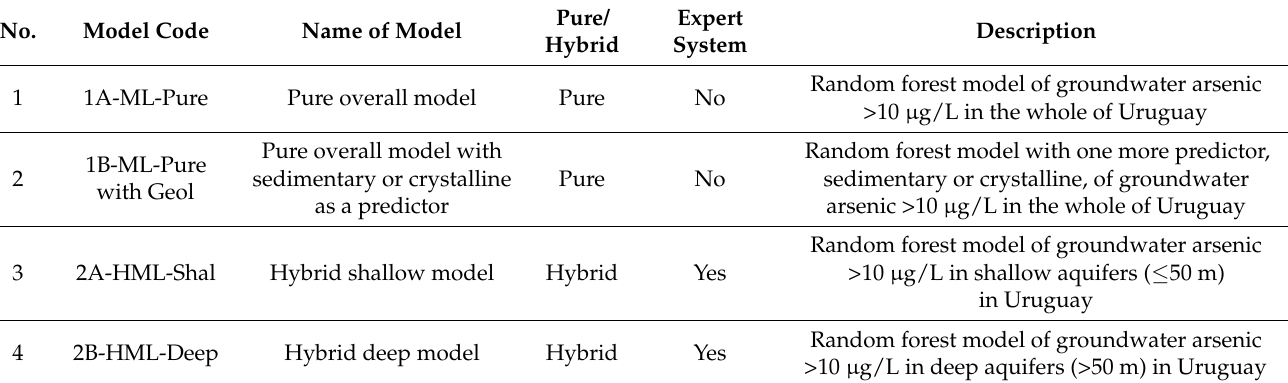
Table 1. Names, types, and descriptions of the models generated in this